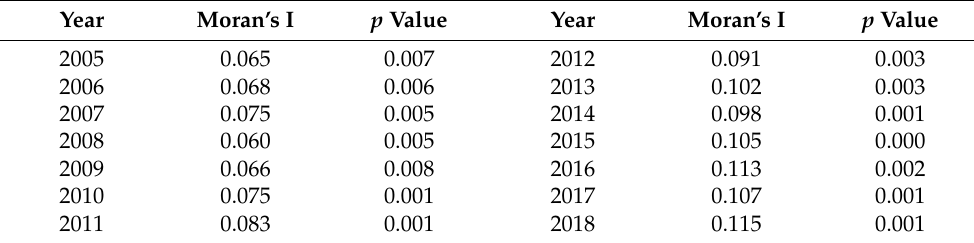
Table 2. Moran’s I of industrial green technology innovation efficiency (GTIE) in